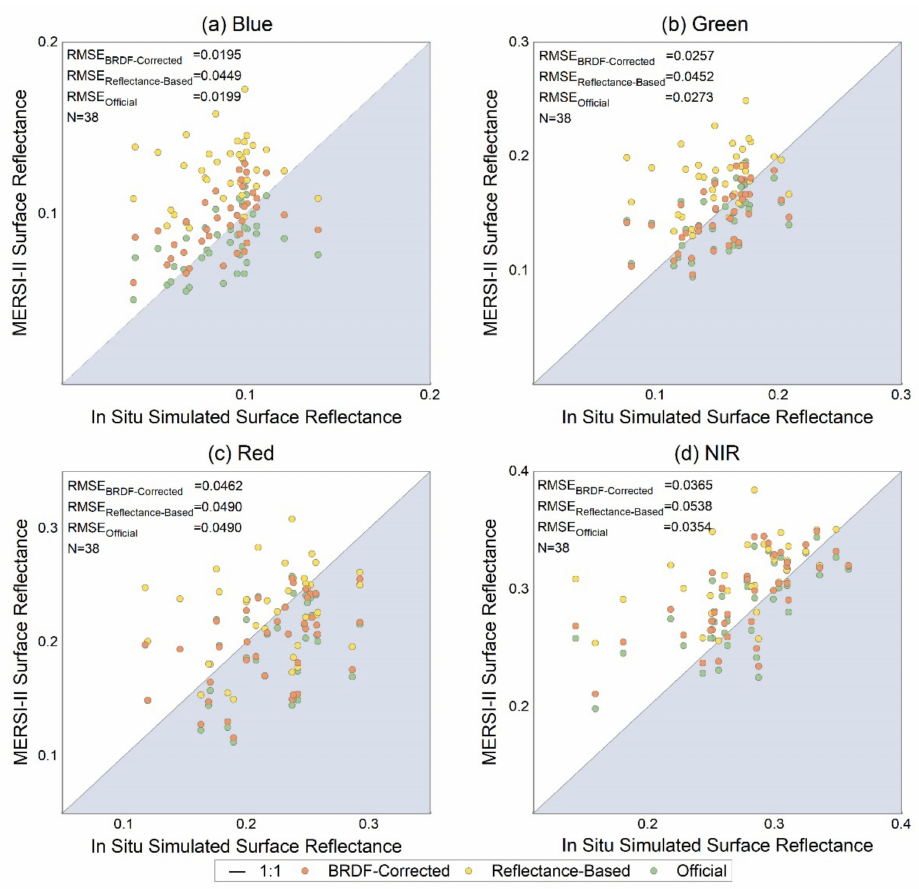
Figure 9. Validation of calibrated surface reflectance of FY-3D MERSI-II using in-situ measurements simulated surface reflectance for the four spectral bands: ( a ) blue band; ( b ) green band; ( c ) red band; ( d ) NIR band. The results of the three versions of calibration coefficients are plotted in this figure. The statistical results of RMSE, and a number of samples are also